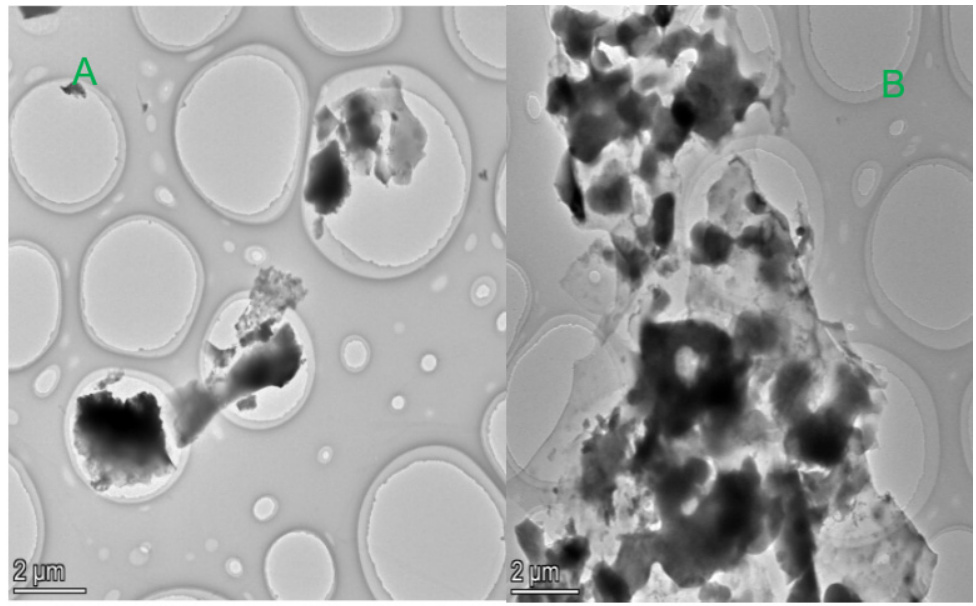
Figure 13. Shape band scan of fly ash pellets before ( A ) and after ( B ) adsorption.